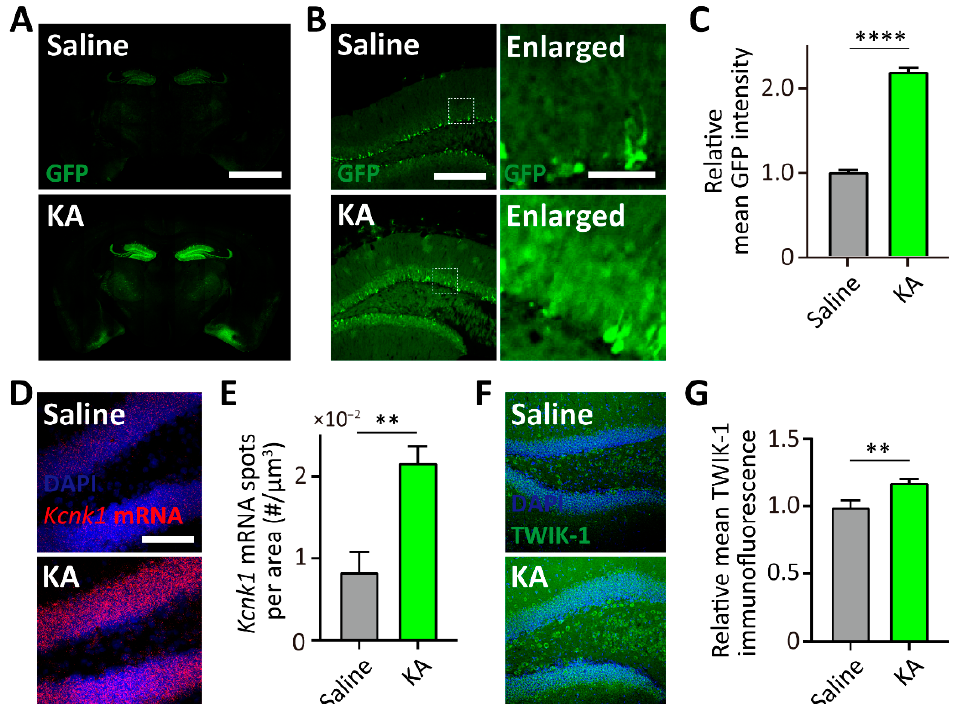
Figure 5. TWIK-1 BAC-GFP Tg mice represent kainic acid (KA)-induced increase of TWIK-1 expres- sion. ( A ) Representative GFP expression in a brain slice from saline or KA-treated TWIK-1 BAC-GFP Tg mice. Scale bar, 1000 µ m. ( B ) Representative GFP expression in the DG from saline or KA-treated TWIK-1 BAC-GFP Tg mice. Scale bar, 200 µ m. Enlarged inset from the experiment. Scale bar, 50 µ m. ( C ) Quantification of relative mean GFP intensity of the granule cell layer. ( D ) Representative Kcnk1 mRNA fluorescence in situ hybridization (FISH) images of DG from saline- or KA-treated mice. Scale bar, 100 µ m. ( E ) Quantification bar graph of Kcnk1 mRNA spot density in the granule cell layer from saline- or KA-treated mice. ( F ) Representative TWIK-1 immunofluorescence images of DG from saline- or KA-treated mice. Scale bar, 200 µ m. ( G ) Quantification bar graph of the relative mean TWIK-1 immunofluorescence in the granule cell layer of saline- or KA-treated mice. Raw data are listed in Supplementary Materials Table S1. **** p < 0.0001; ** p < 0.01, two-tailed t tests. Data are presented as the Mean ± SEM.